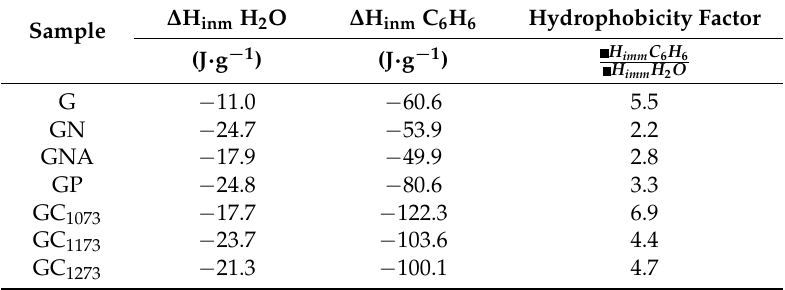
Table 5. Immersion enthalpies in water and benzene, and hydrophobic factor.